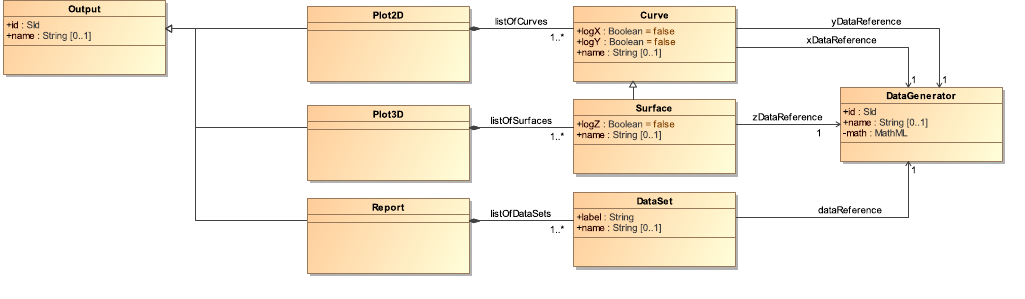
Figure 2.39: The SED-ML Output